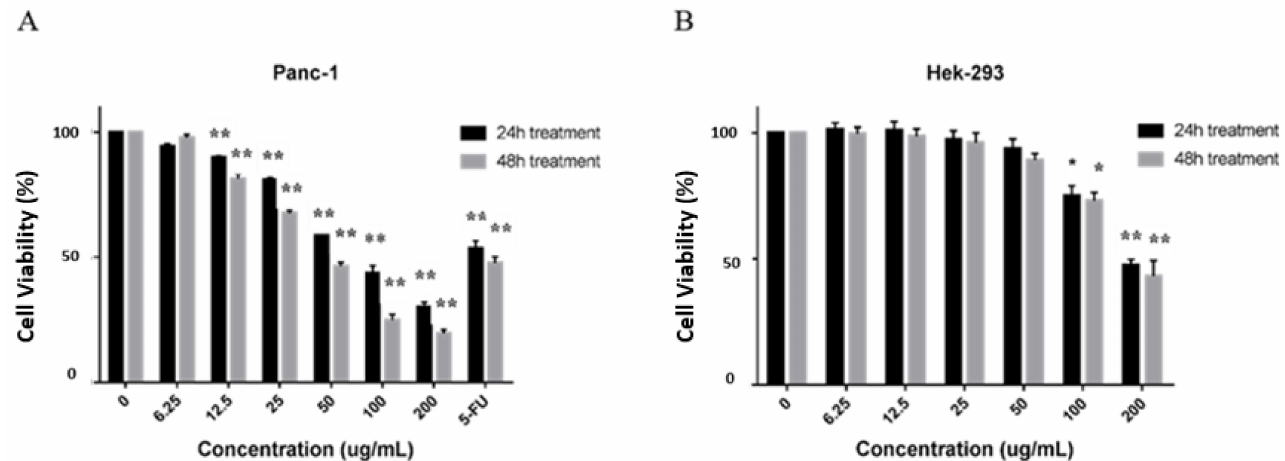
Figure 2. CP inhibited the viability of Panc-1 cells and had little effect on normal Hek-293 cells. ( A ) Panc-1 cells were treated with various concentrations of CP for 24 and 48 h. 50 µ M Fluorouracil (5-FU) was used as a positive control. After treatment, CP exerted an anti-proliferation effect on Panc-1 cells. ( B ) CP showed no cytotoxic effect on normal HEK-293 cells until the concentration reaches 100 µ g/mL. Data are presented as mean ± SD; * p < 0.05 and ** p < 0.01 versus control; n =